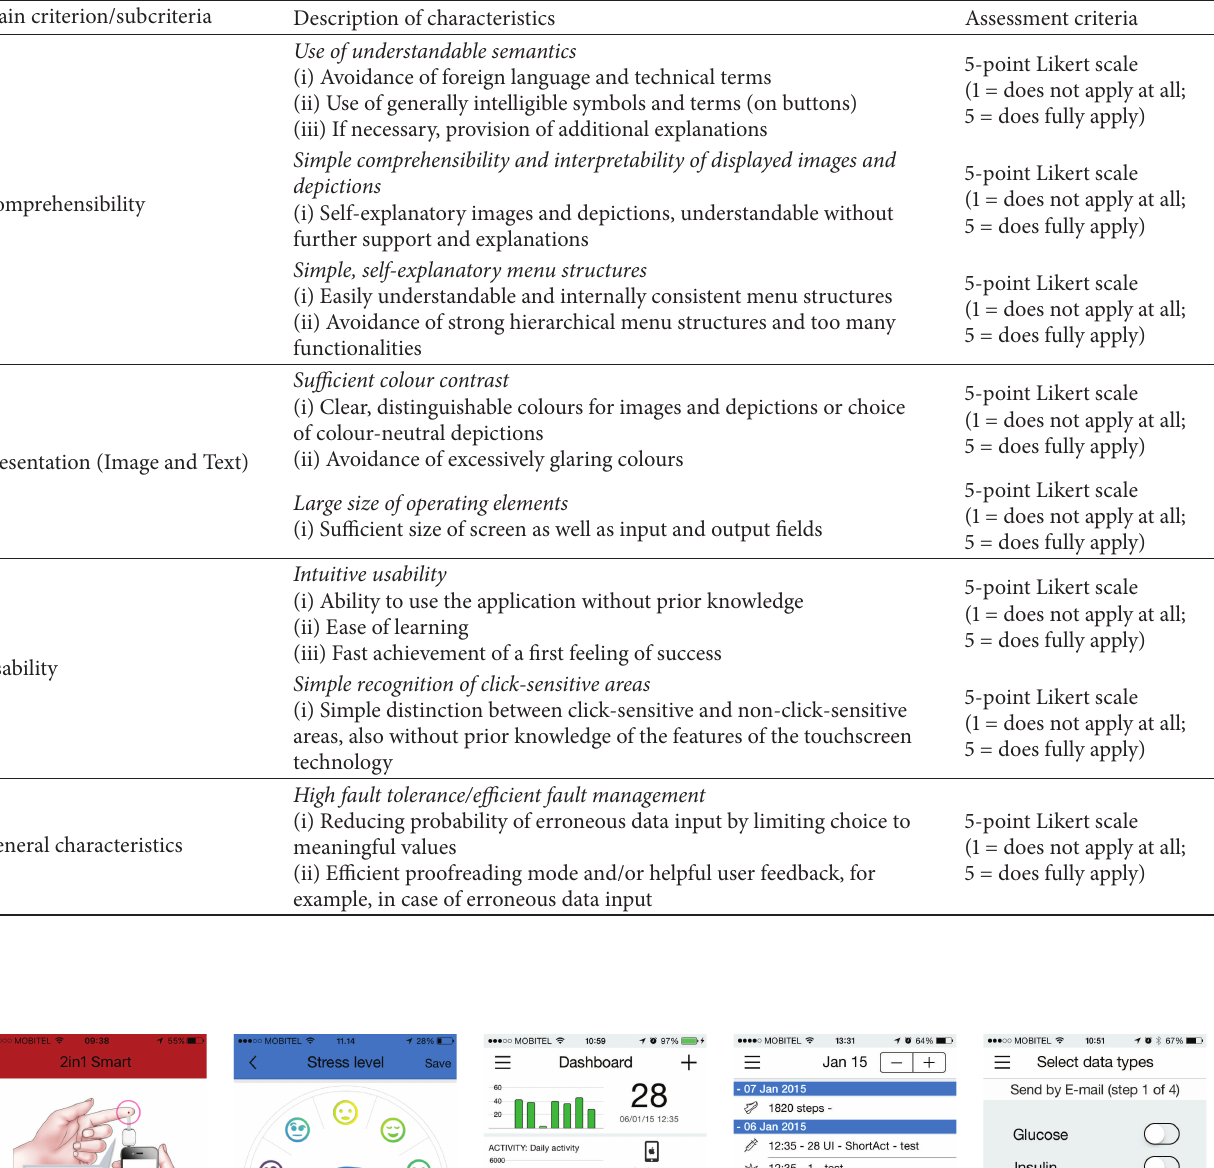
Table 1: Questionnaire used in testing, adapted from [22].